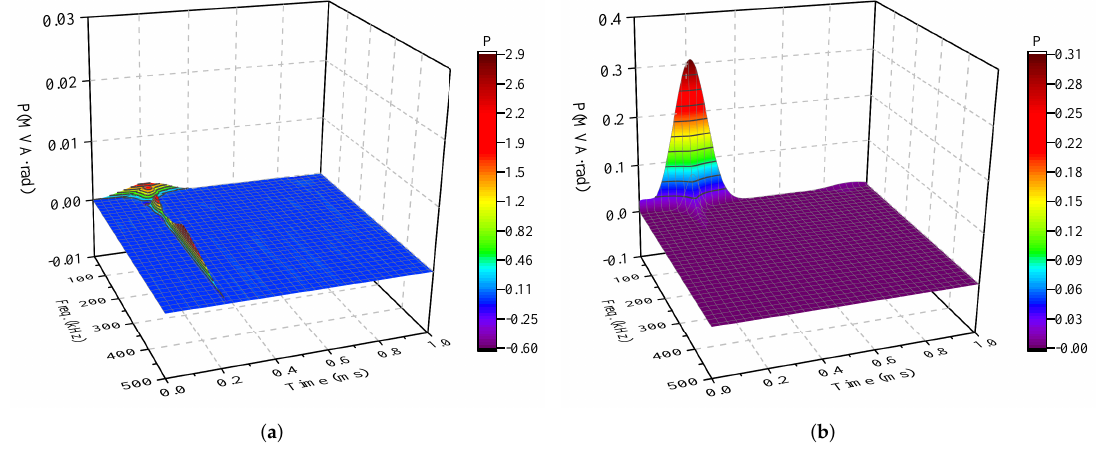
Figure 10. Instantaneous power of both terminals with external fault (F4). ( a ) Instantaneous power of rectifier side. ( b ) Instantaneous power of inverter side.